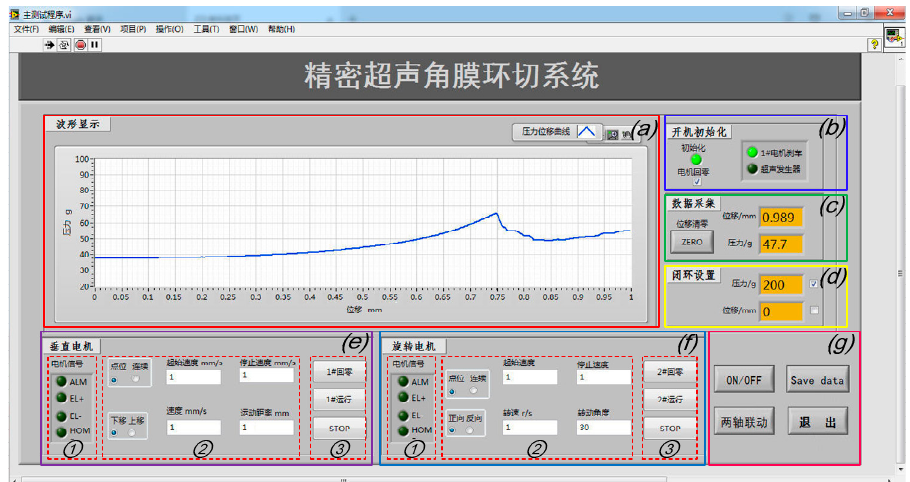
Figure 12. The human–machine interaction interface of the system based on Labview: ( a ) the cutting force–displacement curve real-time display zone; ( b ) system status display zone; ( c ) force and displacement data real-time display zone; ( d ) closed-loop setting zone; ( e ) vertical and ( f ) rotary motor control zone; and ( g ) the main control button zone.